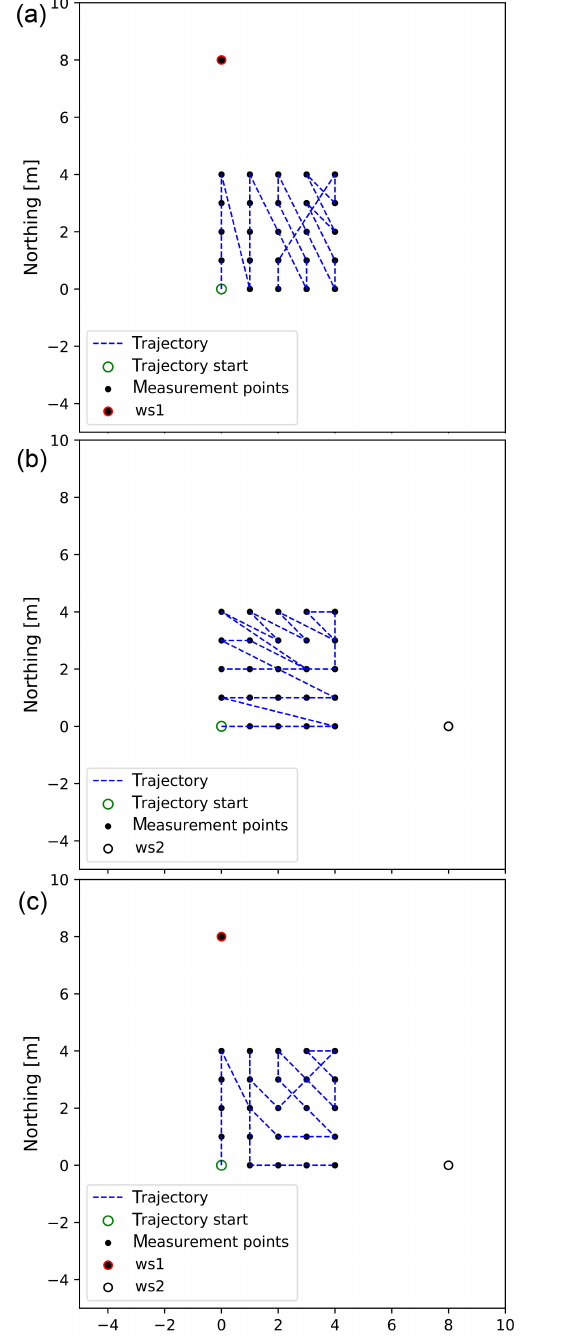
Figure 4. TSP NNH: (a) standard TSP NNH for lidar denoted ws1; (b) standard TSP NNH for lidar denoted ws2; (c) adapted TSP NNH for two lidars denoted ws1 and